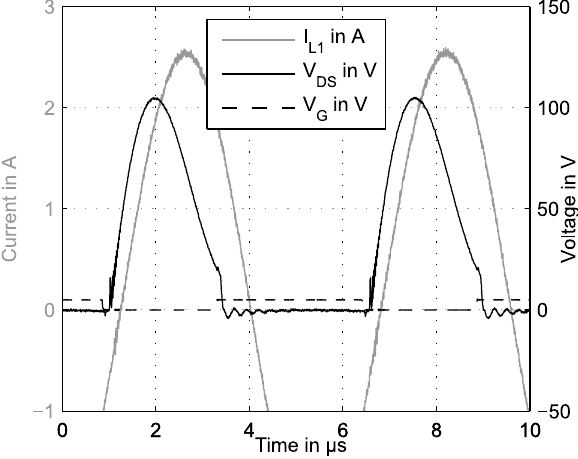
Figure 8. The amplifier is mistuned at its maximum power of 55